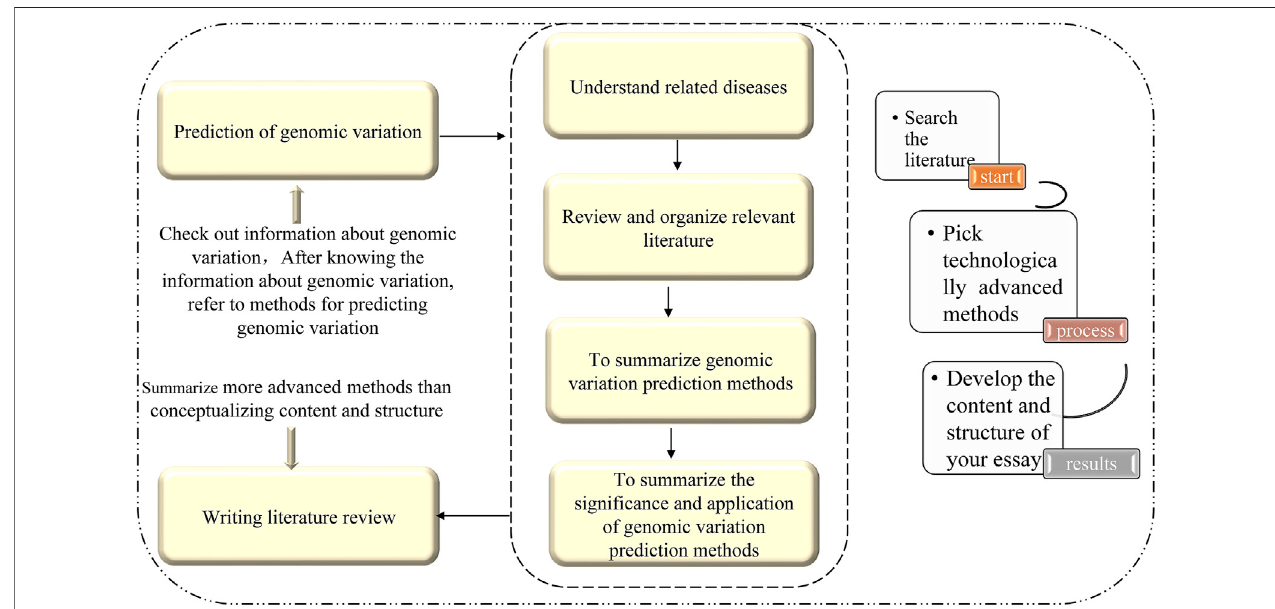
FIGURE 1 | Idea map of the